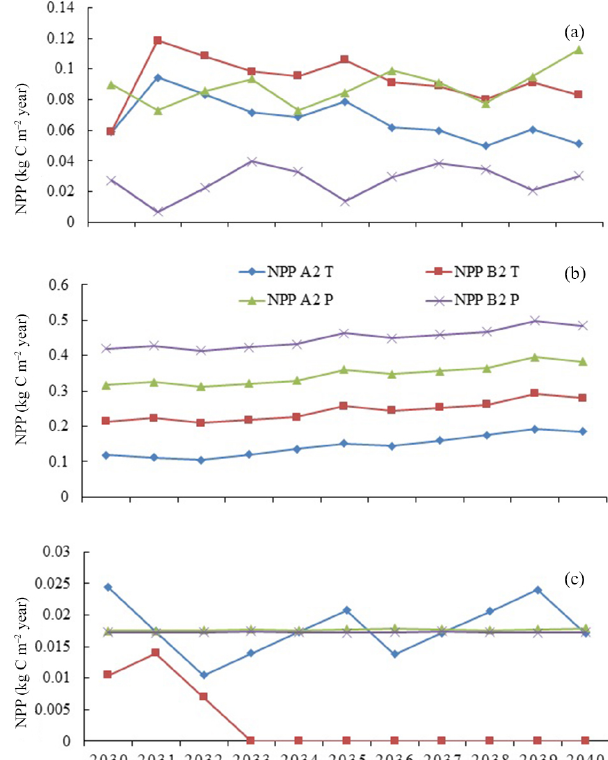
Figure 10. The NPP annual average in range lands (a) , forests (b) and deserts (c) in 2030. NPP B2T is the NPP under the thermal pattern on B2 emission scenario, NPP A2T is the NPP of thermal under A2 emissions scenario, NPP A2P is the NPP of thermal un- der A2 emissions scenario and NPP B2P is the NPP model under thermal emission B2